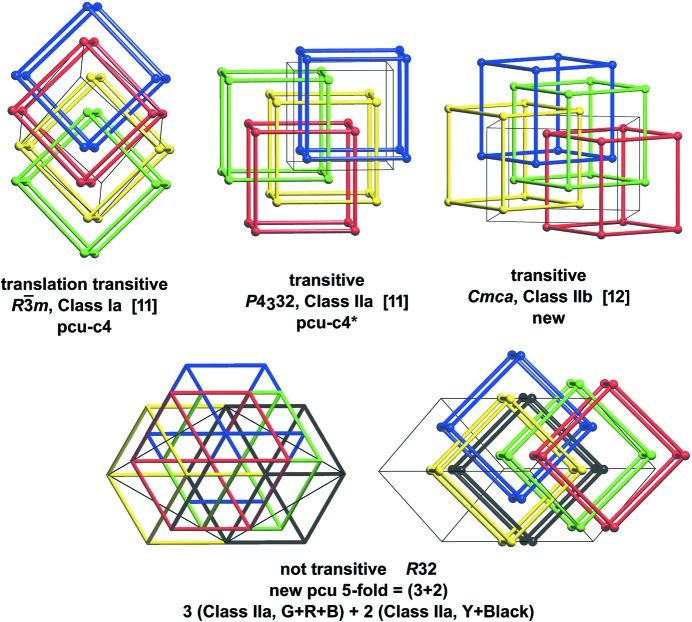
Four examples of shift-homogeneous n-grids with interpenetration class according to Baburin et al. (2005 ▸), the vertex and edge transitivity [ve] and the RCSR names where available.